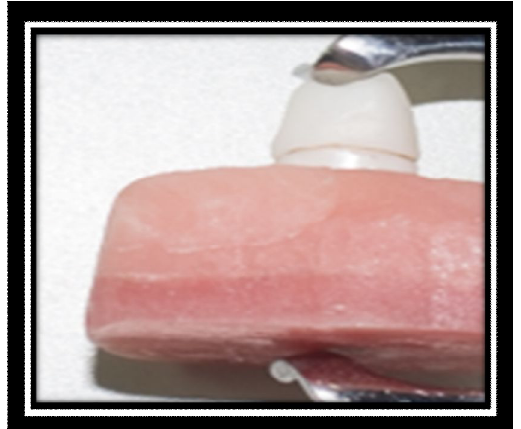
Figure 8: Master die with crown in the holding device.